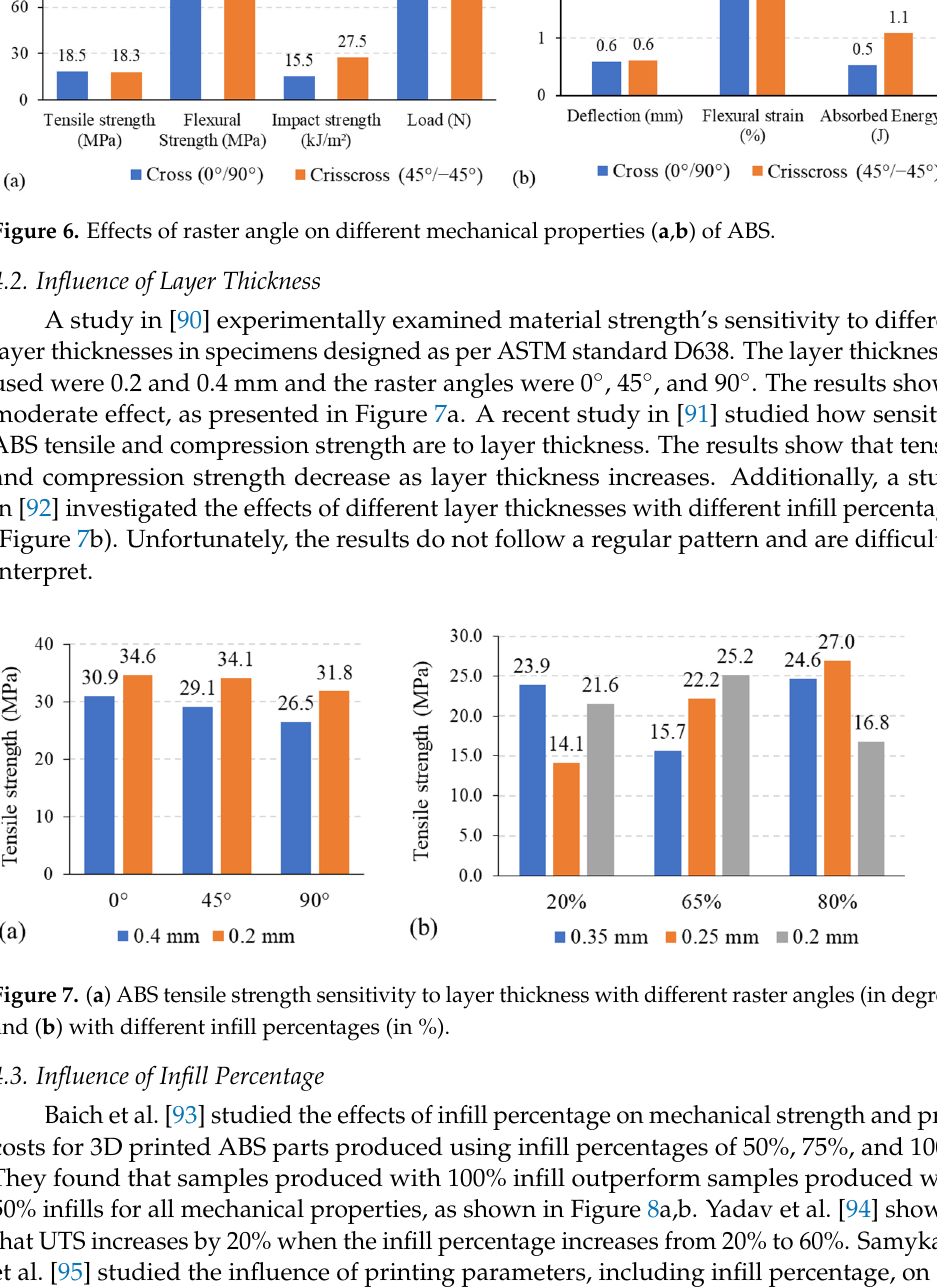
grees) and ( b ) with different infill percentages (in %). and ( b ) with different infill percentages (in